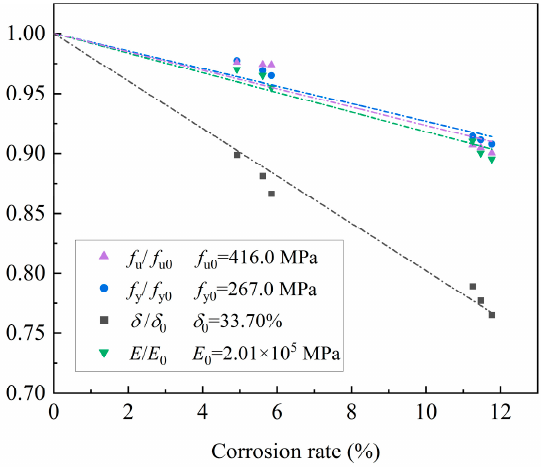
Figure 9. Relationship between the mechanical properties and corrosion rate of the steel beams.